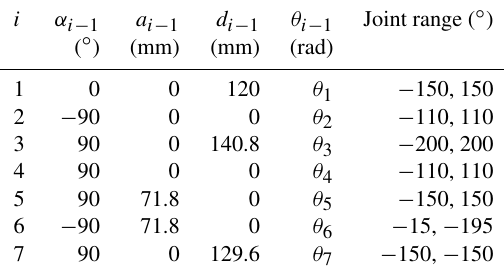
Table 1. D–H parameters.